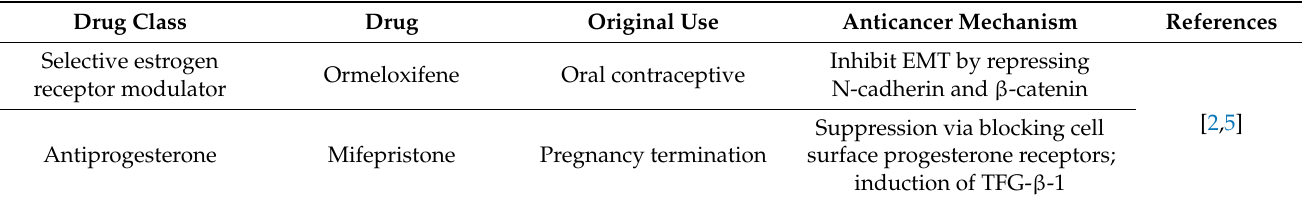
Table 2. Examples of drugs that were originally used in women but show anticancer activity in prostate